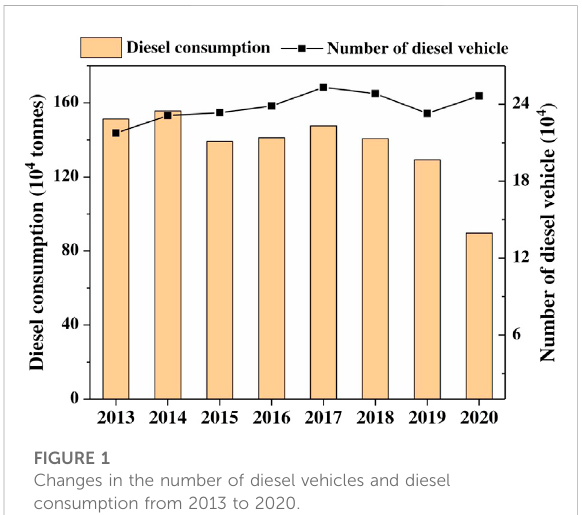
FIGURE 1 Changes in the number of diesel vehicles and diesel consumption from 2013 to